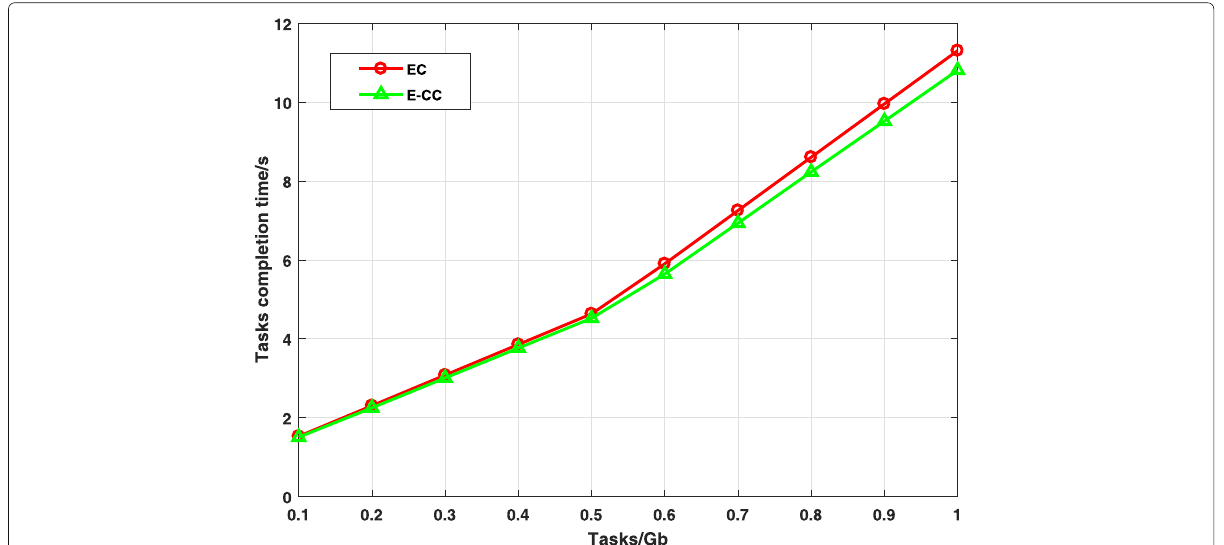
Fig. 3 Impact of cloud server on completion